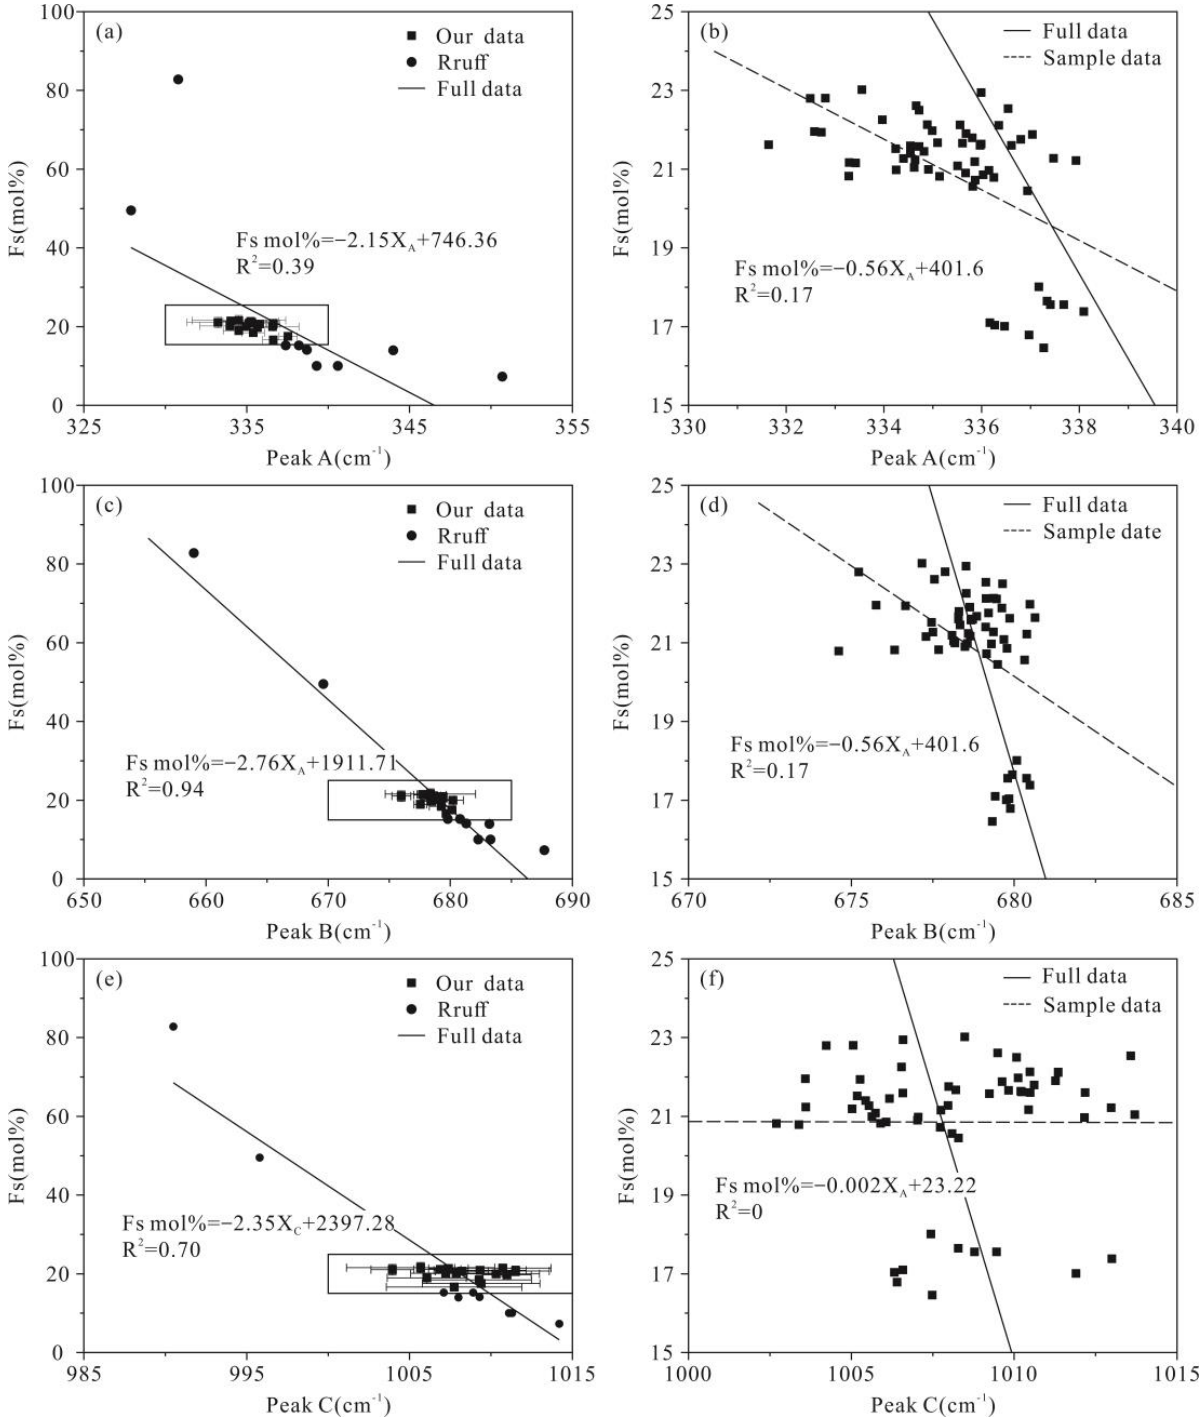
Figure 4. Correlation between the Fs content in olivine and the Raman shift of two selected peaks. ( a , c , e ) show the results of the fitting from all the data. ( b , d , f ) show the results of the fitting from our data only. The correlation curve has been calculated using the reference data (circles) and our measurements (filled squares) are plotted for comparison. The error bars represent the standard deviation for 3–5 Raman spectra analyses per chondrite.